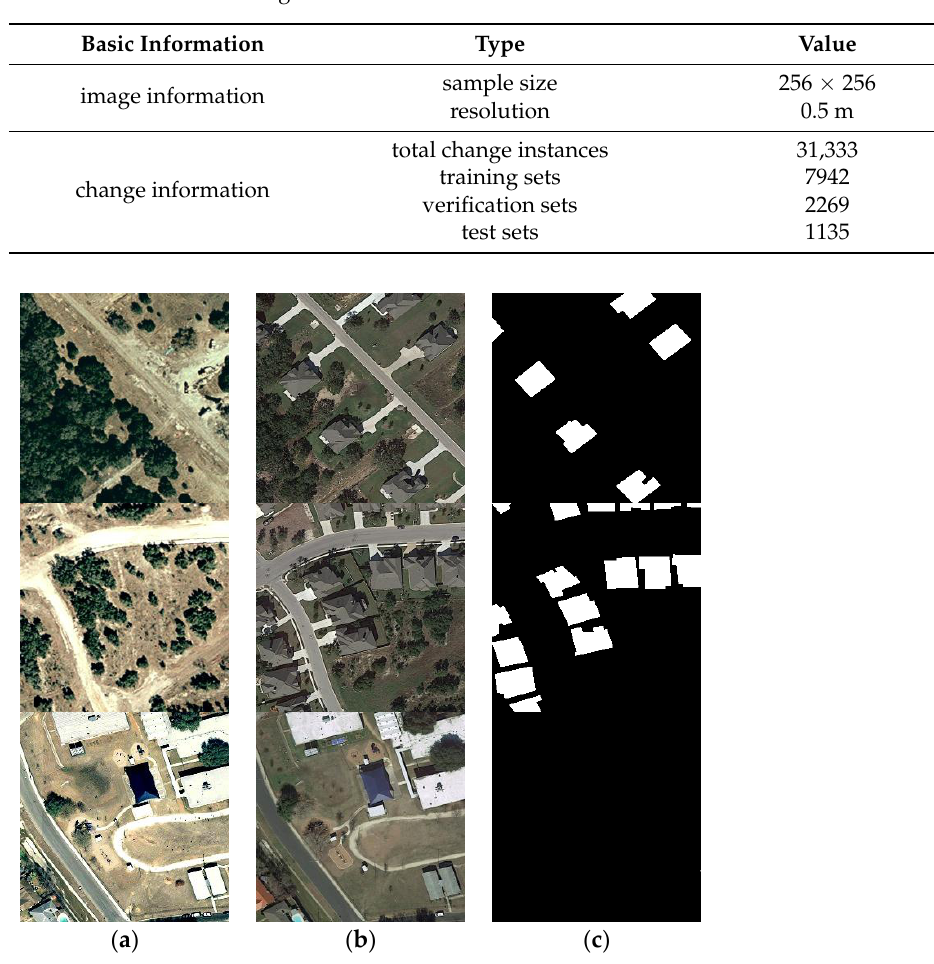
( e ) Figure 8. Training sample. ( a ) Image1; ( b ) Image2; ( c ) Positive Clicks; ( d ) Negative Clicks; ( e ) La- bel. Based on the PyTorch deep-learning framework, we deployed all training data and code in one unit with the Ubuntu16.04.4 system server. The server processor is a Core i7-